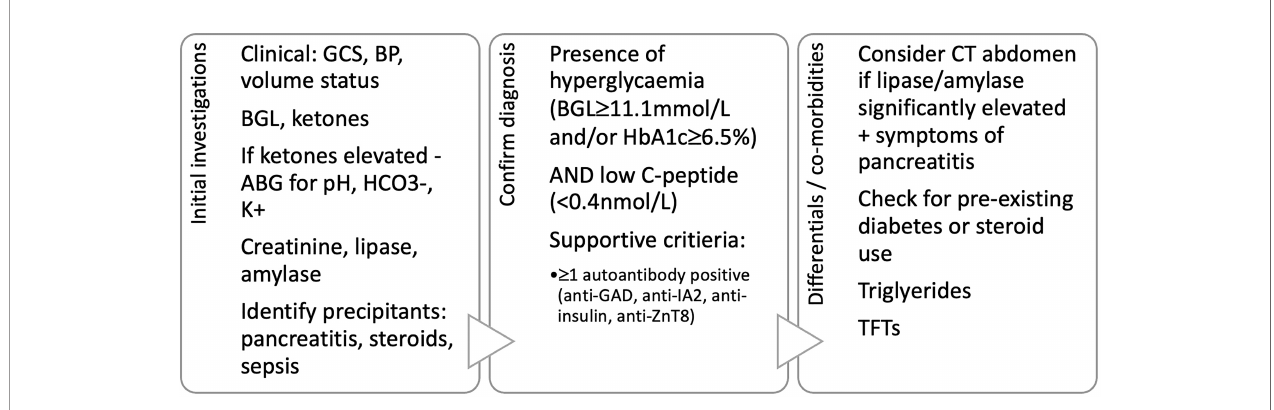
FIGURE 3 | Proposed diagnostic criteria and initial investigations in patients presenting with hyperglycaemia after immune checkpoint inhibitor use. GCS, Glasgow coma scale; BP, blood pressure; BGL, blood glucose level; ABG, arterial blood gas; HCO3-, serum bicarbonate; K+, serum potassium; TFTs, thyroid function